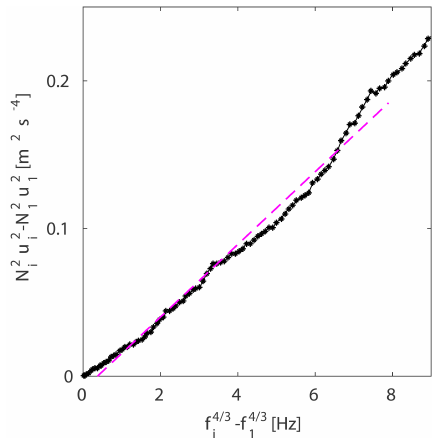
u 2 with filter cutoff f cut calculated for the i i